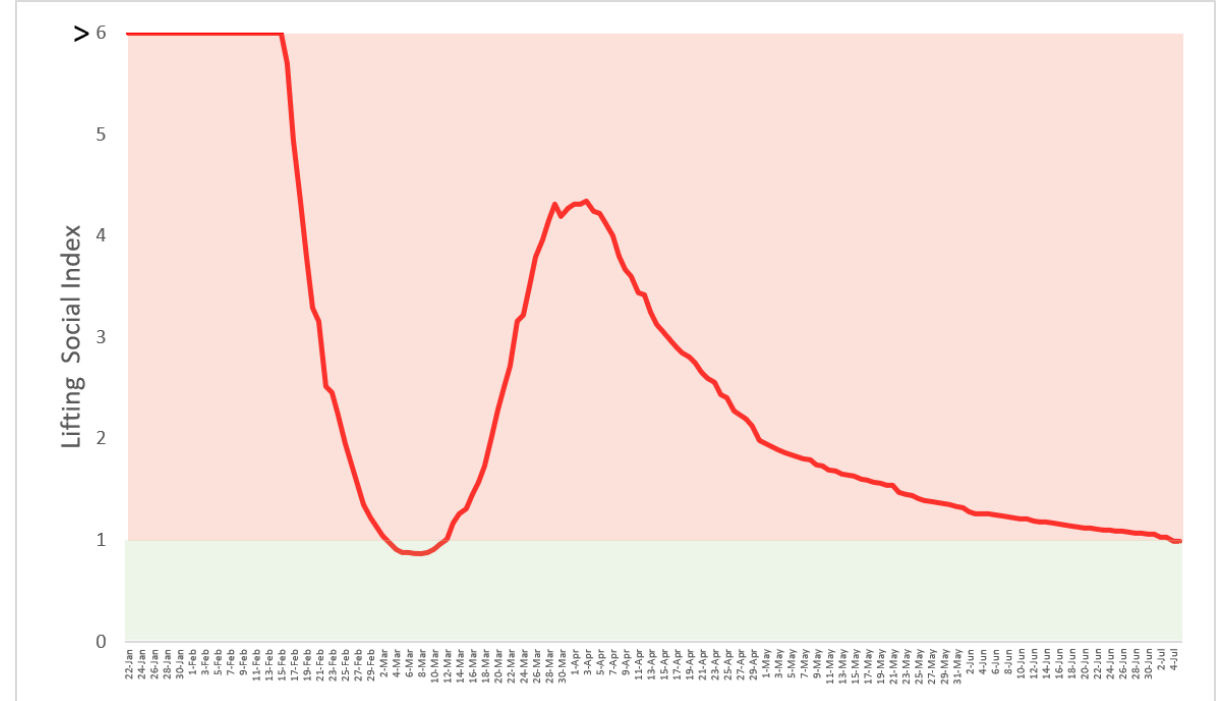
Figure 1. Temporal trend of global lifting social distancing (LSD) index up to July 5, 2020. Overall: The LSD index ranged between 40.1 and 0.96 in the prepandemic period from January to mid-March. In the pandemic period from mid-March to June, the peak of the LSD index reached 4.27 on March 29. As of July 5, the LSD index declined to less than